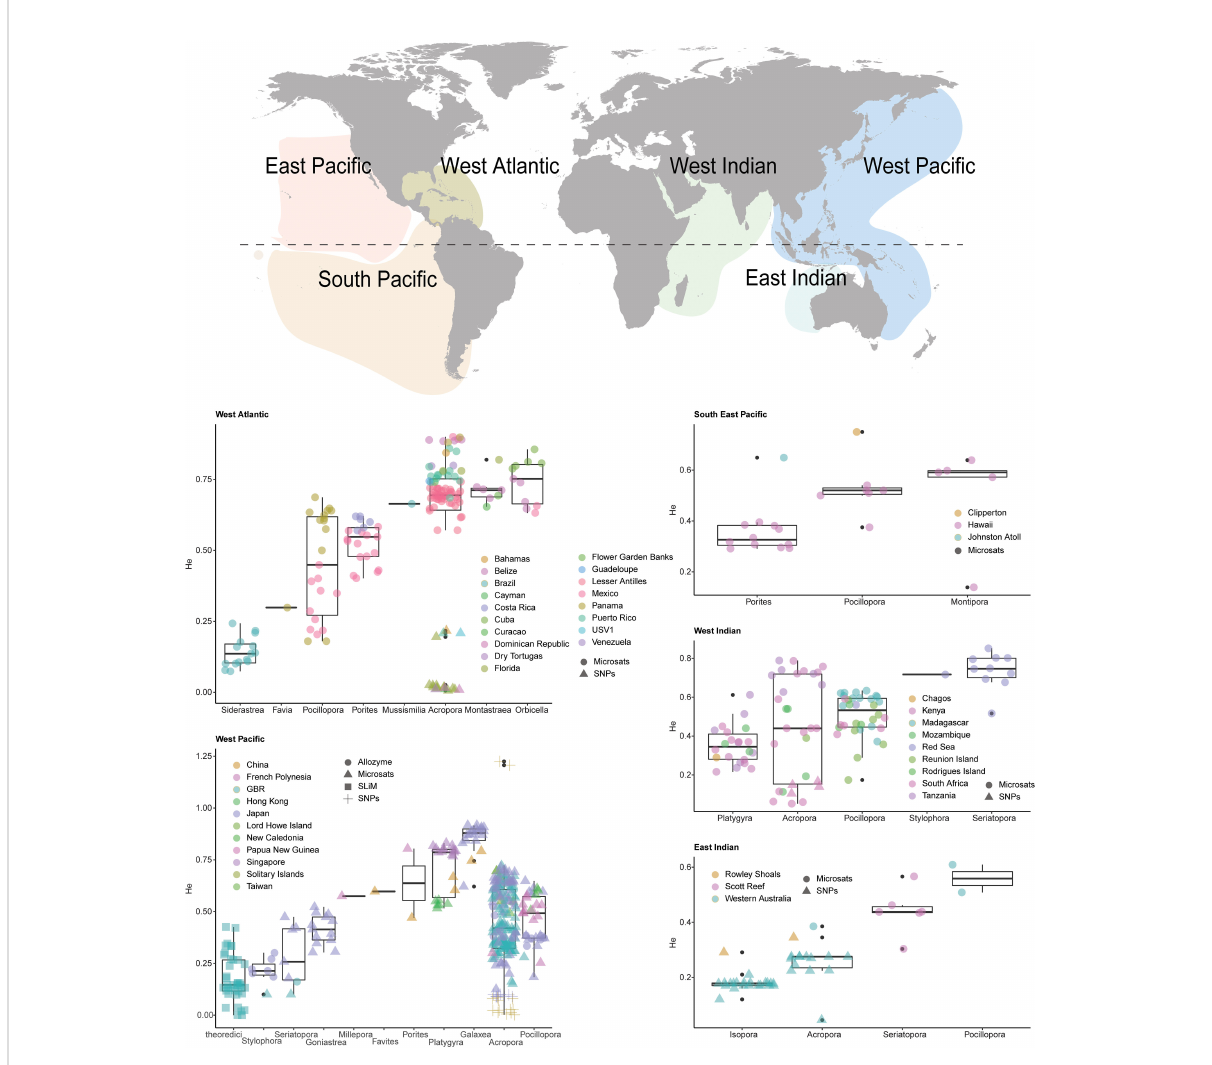
FIGURE 6 Spatial and taxonomic patterns of genetic diversity (He) in reef-building corals from a global metaanalysis using a Web of Science search (heterozygosity AND coral, expected heterozygosity AND coral, genetic diversity AND coral (1991-